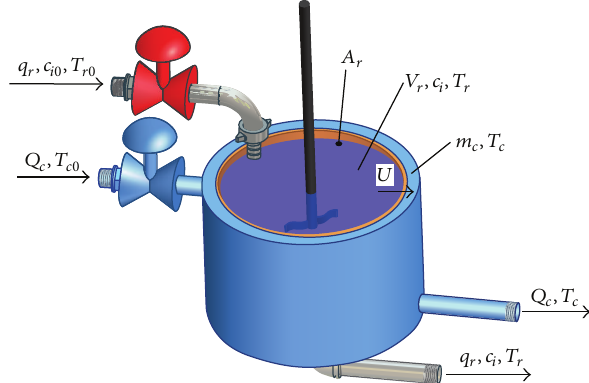
Figure1:Continuousstirred-tankreactorwithcoolinginthejacket.